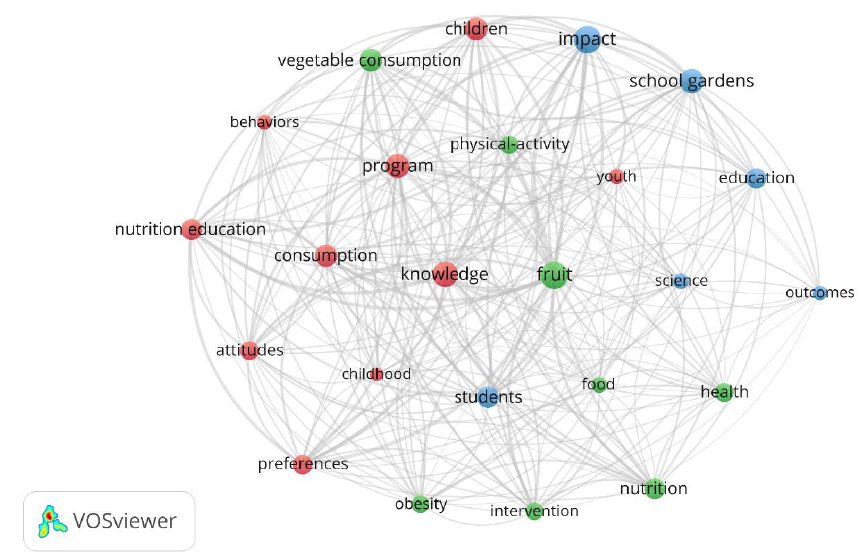
Figure 8. Keywords Plus co-occurrence graph.